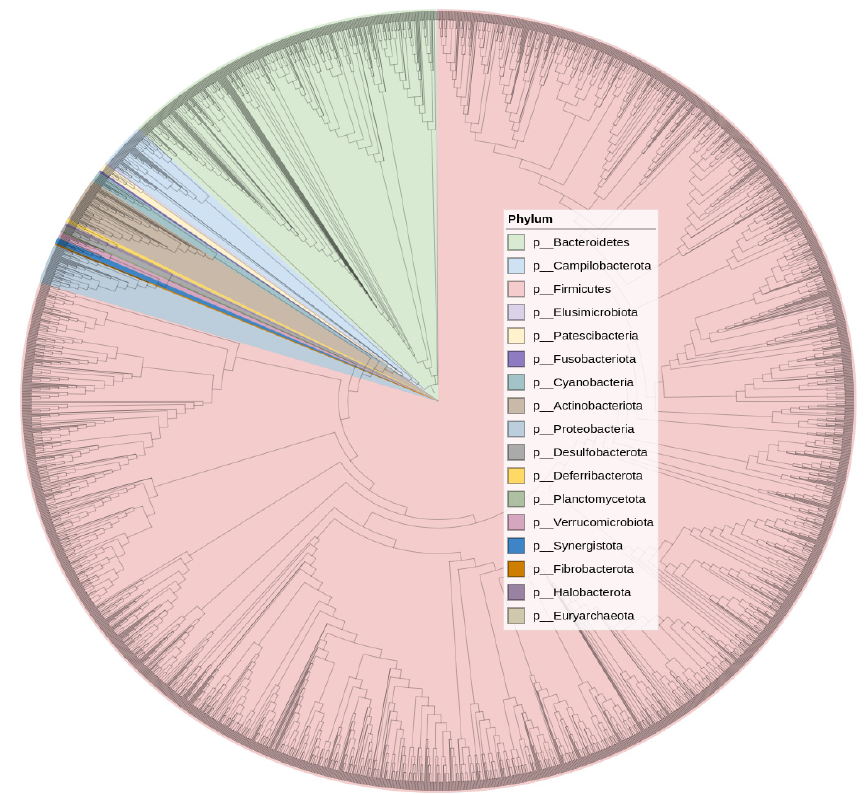
Figure 4. Phylogenetic tree diagram.